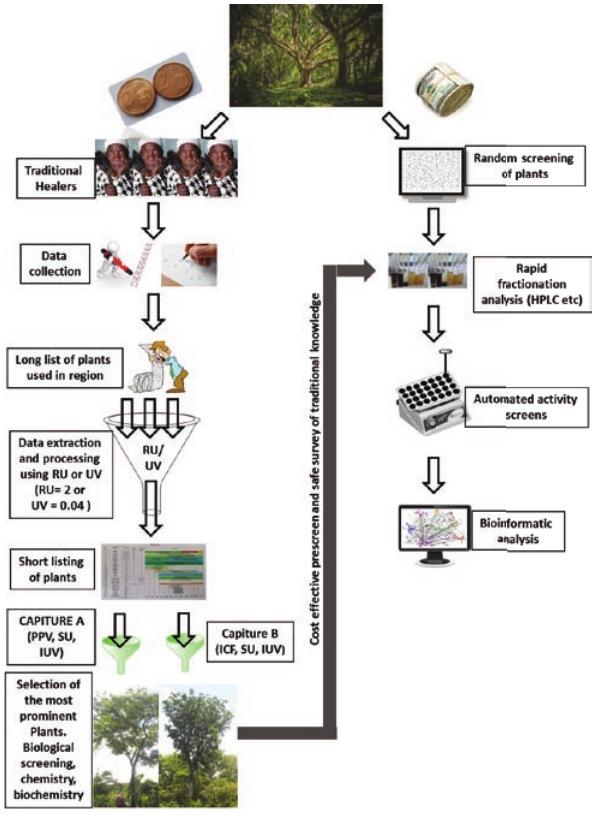
Figure 2: A schematic overview of the CAPITURE